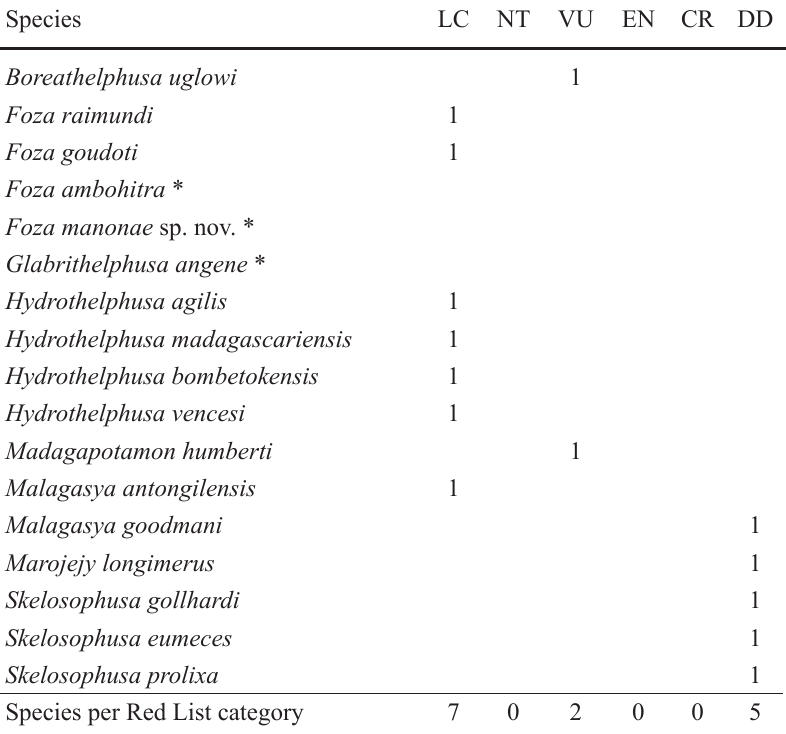
Table 2. Summary of the freshwater crabs found in Madagascar, with their conservation status assessed using the IUCN Red List protocols (based on data from Cumberlidge et al. 2009). Non-threatened categories: LC = Least Concern, NT = Near Threatened. Threatened categories: VU = Vulnerable, EN = Endangered, CR = Critically Endangered. Other categories: DD = Data Deficient. * = not